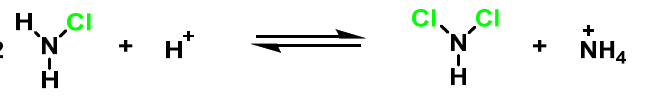
Figure 19. Dihaloamines obtained by the disproportionation reaction of the corresponding N -monohaloamine in an acid medium.